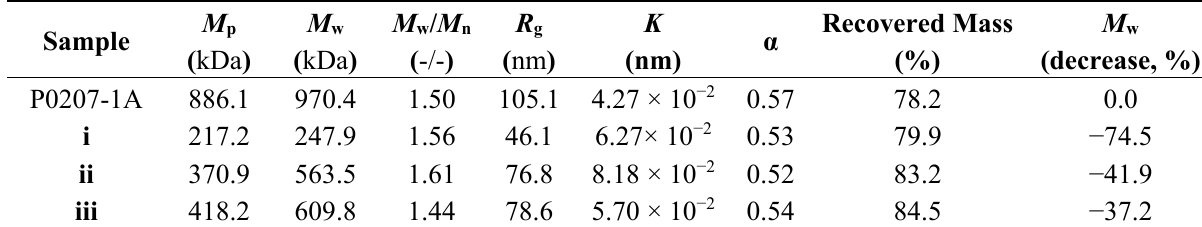
Table 1. Summary of SEC-MALS results of four